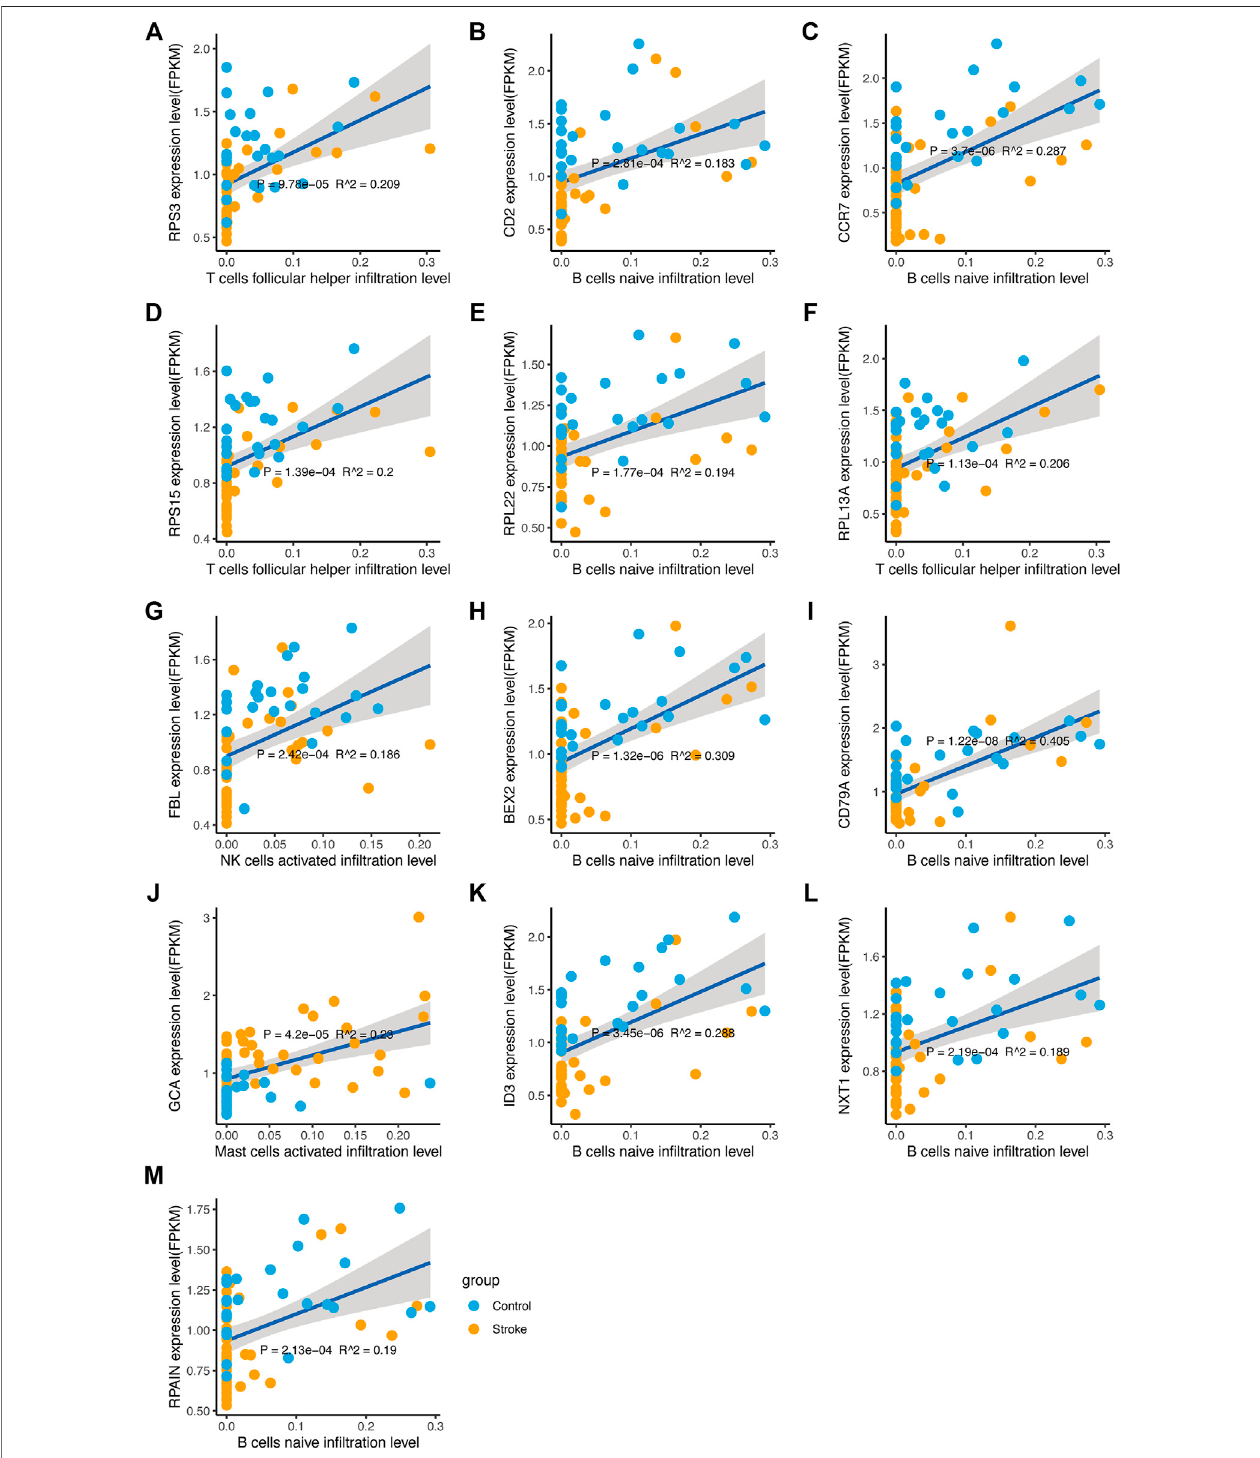
FIGURE 12 | Correlation between diagnostic markers and immune cell in fi ltration. (A – M) The linear regression of diagnostic markers and immune cell in fi ltration level. The horizontal axis indicates the immune cell in fi ltration level, and the vertical axis indicates the marker expression. The p value is the regression signi fi cance level, and R 2 is the goodness-of- fi